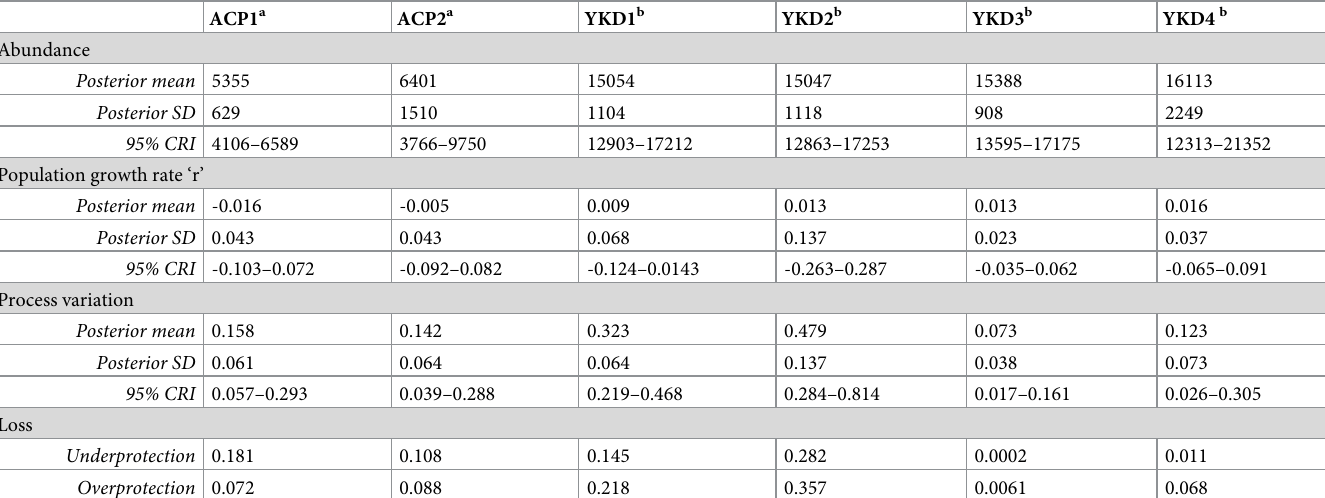
Table 3. Posterior estimates of population metrics and misclassification error for both Alaskan breeding populations of spectacled eiders ( Somateria fischeri)